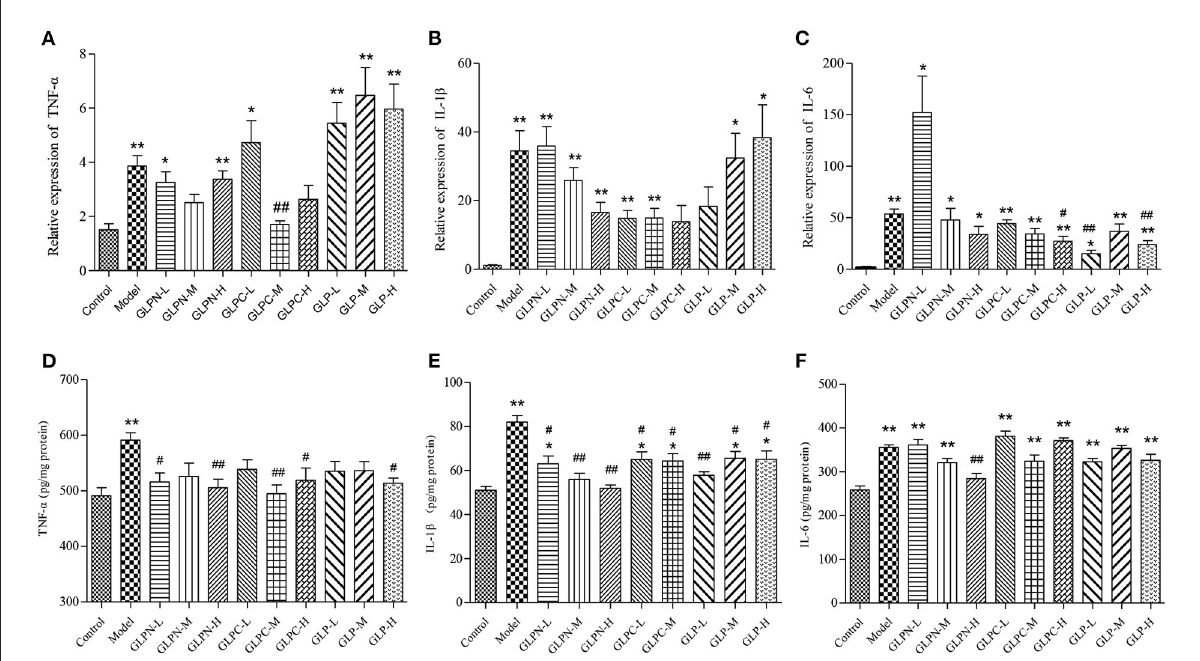
FIGURE7 Effects of GLP and the degraded fractions (GLPC and GLPN) on mRNA and protein expression levels of pro-inflammatory cytokines in the colon tissues of different groups of mice. (A–C) Represent mRNA expression levels of TNF- α , IL-1 β , and IL-6 determined by RT-PCR, respectively. (D–F) Represent the expression levels of TNF- α , IL-1 β , and IL-6 in colon tissues determined by ELISA, respectively. Data are expressed as mean ± SD, n = 10 (* P < 0.05, ** P < 0.01 vs. normal control group; # P < 0.05, ## P < 0.01 vs. DSS model